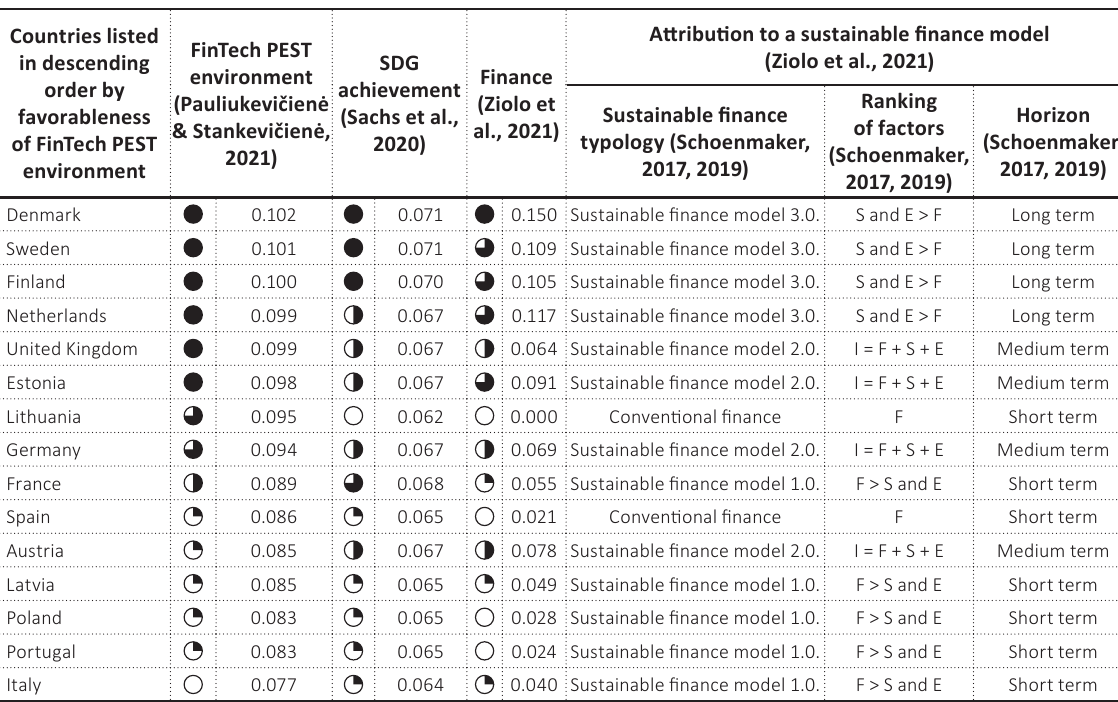
Table 9. Overall trend among the 15 countries in FinTech PEST environment, SDG achievement, and finance